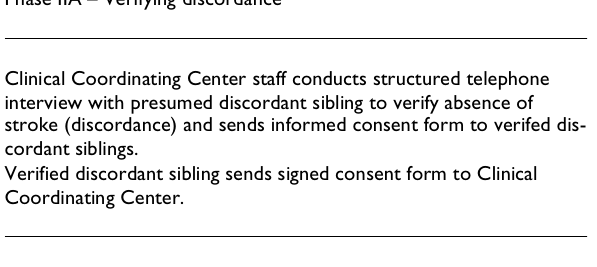
Study neurologist identifies patient who meets criteria for